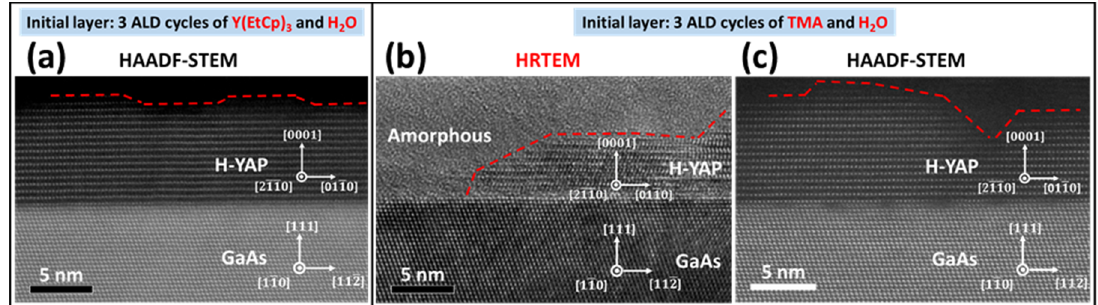
Figure 3. ( a ) Cross-sectional HAADF-STEM image of sample A after 900 °C annealing, showing a uniform single-crystal single-domain H-YAP across GaAs(111)A with an atomically smooth interface, while ( b ) is a cross-sectional HRTEM image of sample B after 900 °C annealing, showing a non-uniform film consisting of regions of single-crystal H-YAP and amorphous area. Figure 3 ( c ) is a cross-sectional HAADF-STEM image of sample B after 900 °C annealing, showing island-like H-YAP domains. HAADF-STEM images were viewed along the H-YAP [2110] zone axis, which is also the GaAs [110] zone axis.